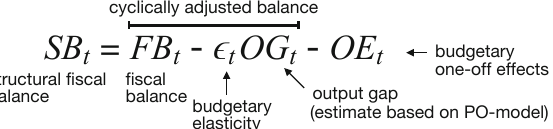
Figure 1 Structural fi scal balances based on output gap estimates